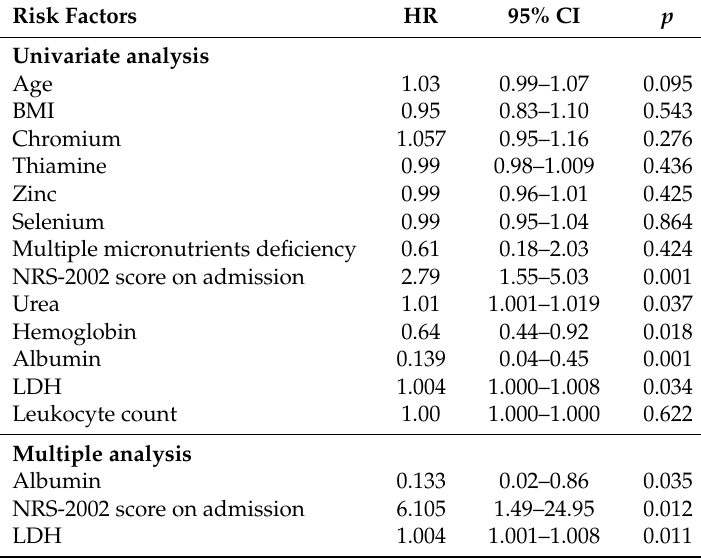
Table 5. Risk factors associated with hospital death according to univariate and multiple Cox’s regression. Risk Factors